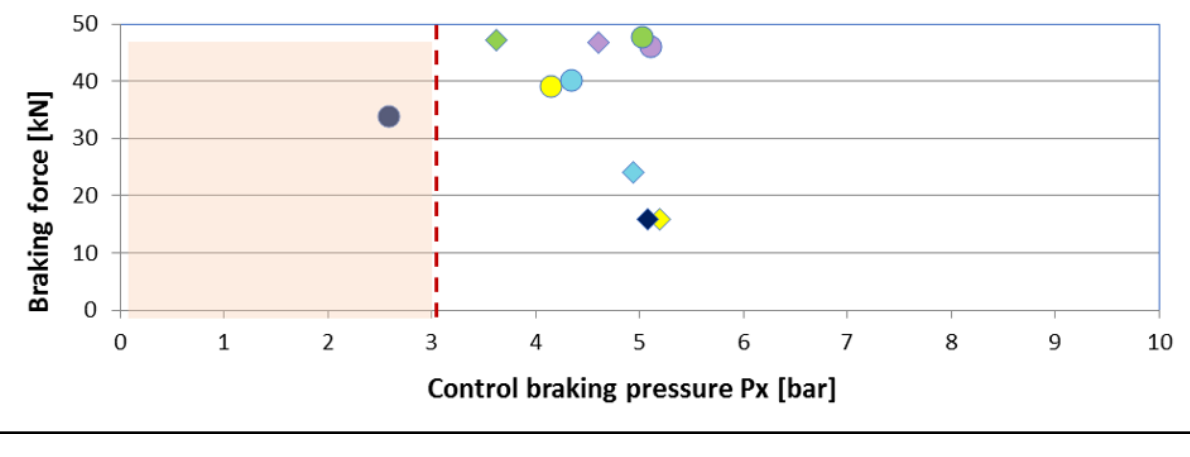
Figure 2: Dependence of braking forces on tractor control pressure.